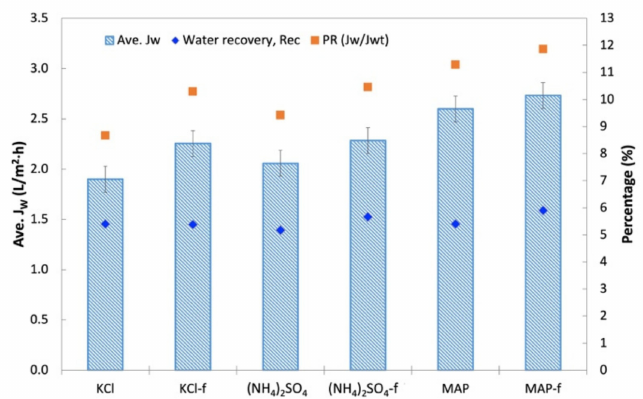
Figure 11. Average water flux, J W , of various DSs and corresponding water recovery, Rec, and percentage flux